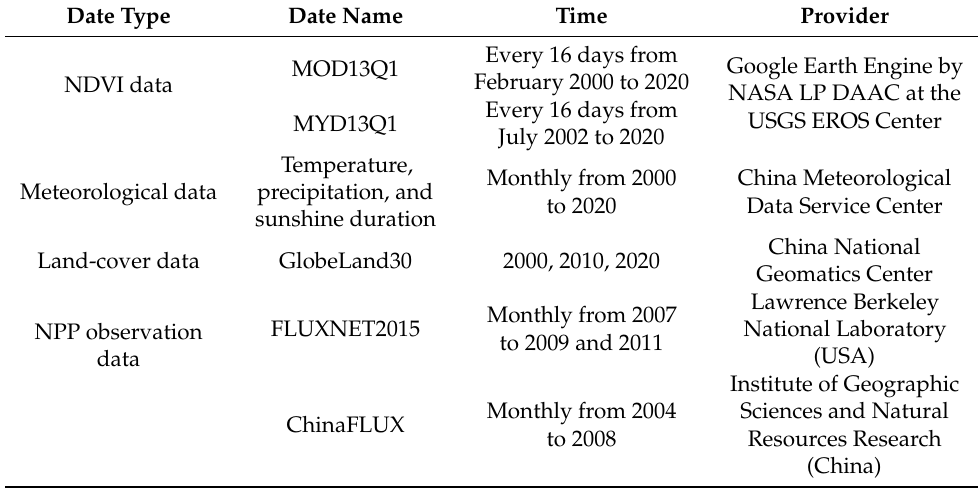
Table 1. Description of data used in this